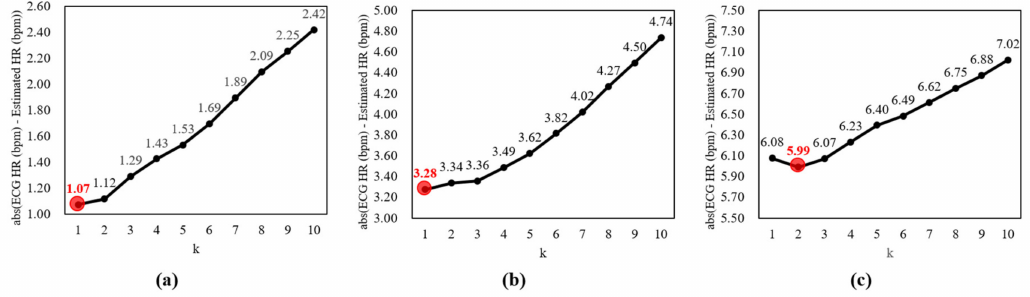
Figure 8. Di ff erences between labels and estimates according to k parameter for heart rate estimation. ( a ) Normal dataset without facial expressions and voluntary head motions, ( b ) dataset with facial expressions, ( c ) dataset with facial expressions and voluntary head motions.